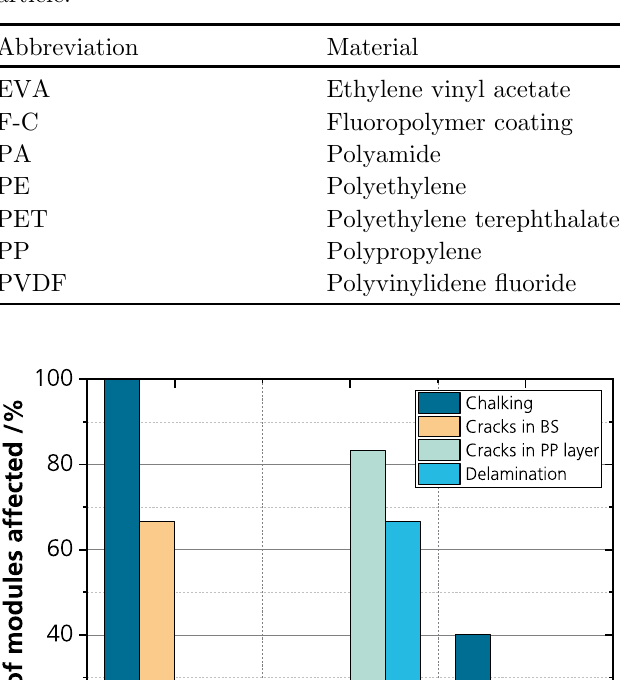
Table 1. Abbreviations of materials used throughout this